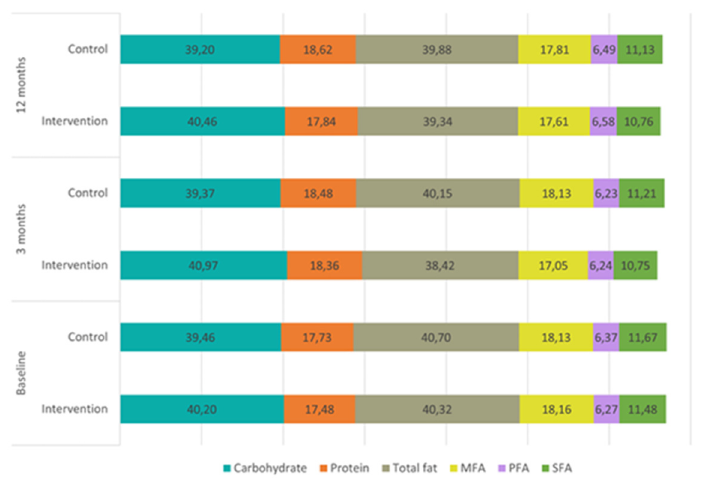
Figure 3. Dietary composition by energy percentage of the main nutrients per visit for each study group. SFA: Saturated Fatty Acids; PFA: Polyunsaturated Fatty Acids; MFA: Monounsaturated Fatty Acids. Table 3. Effect of the intervention on the intake of macronutrients at 3 and 12 months.